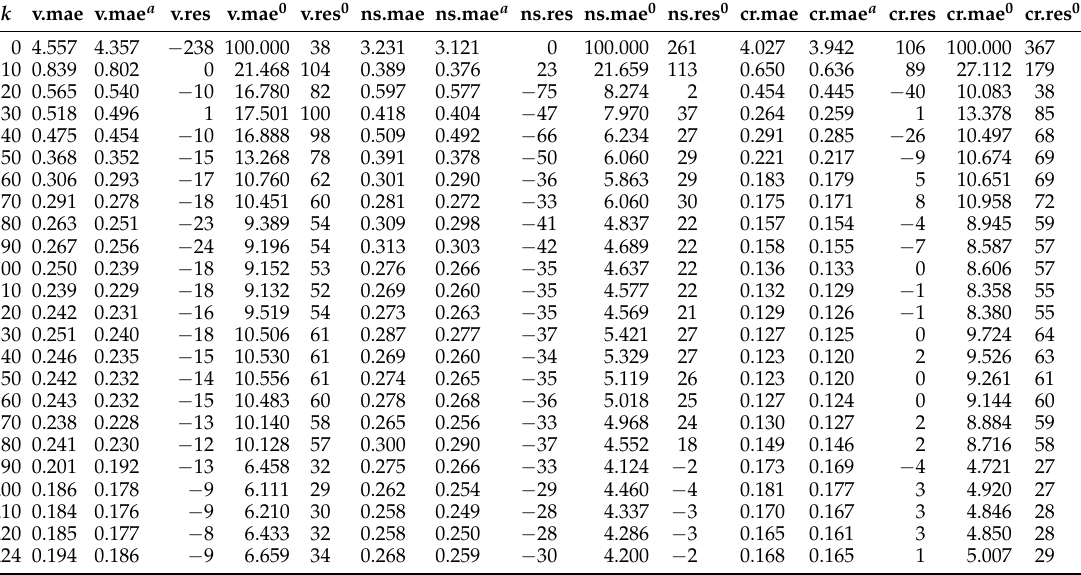
Table A6. Out-of-sample validation figures of the OLS proxy function of BEL under 300–886 after each tenth and the final iteration.